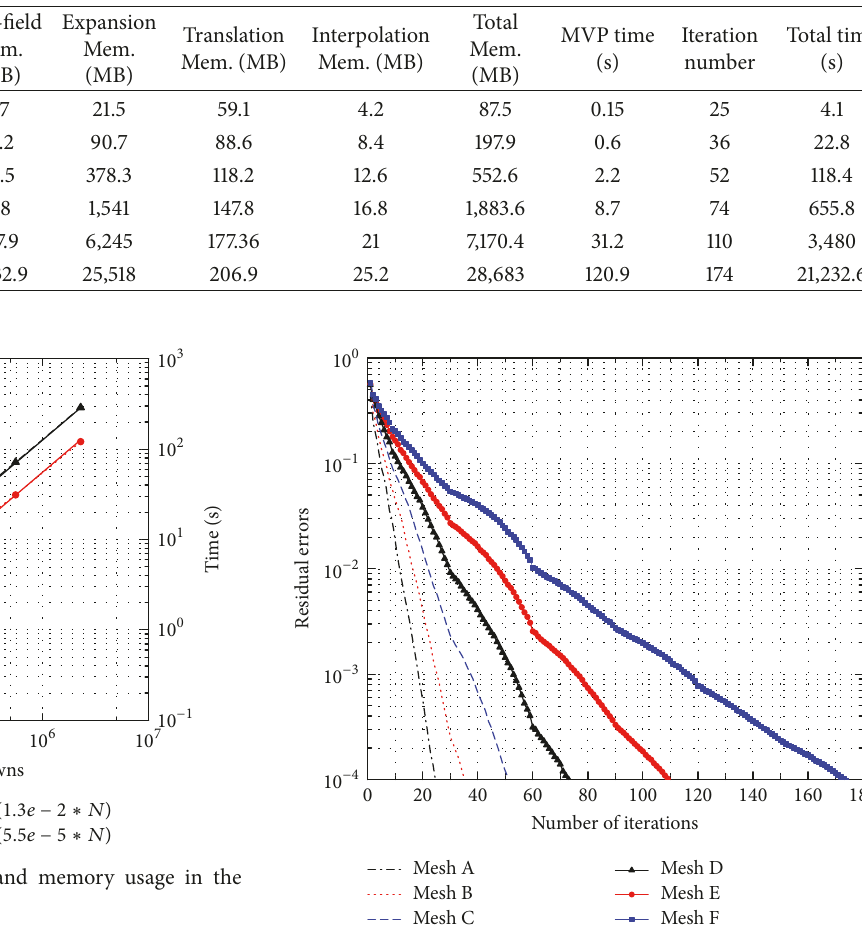
Figure 3: Iteration history of the PEC cube for different